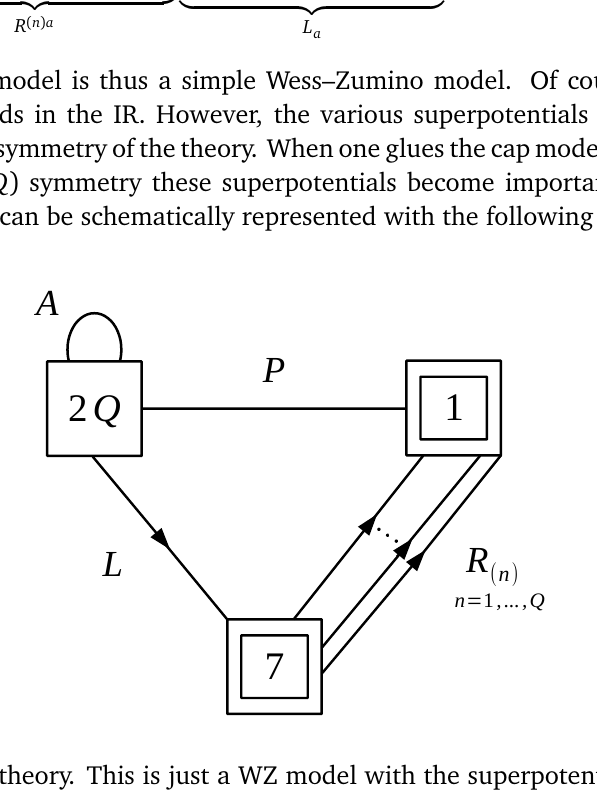
Figure 3: The cap theory. This is just a WZ model with the superpotentials detailed in